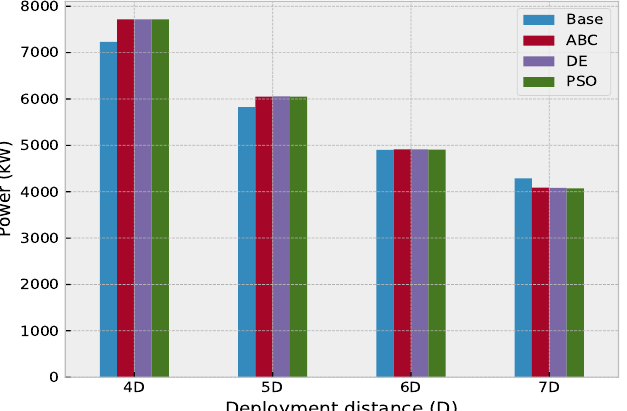
Figure 17. Total plant power for all deployment distances, at 10 m/s mean wind